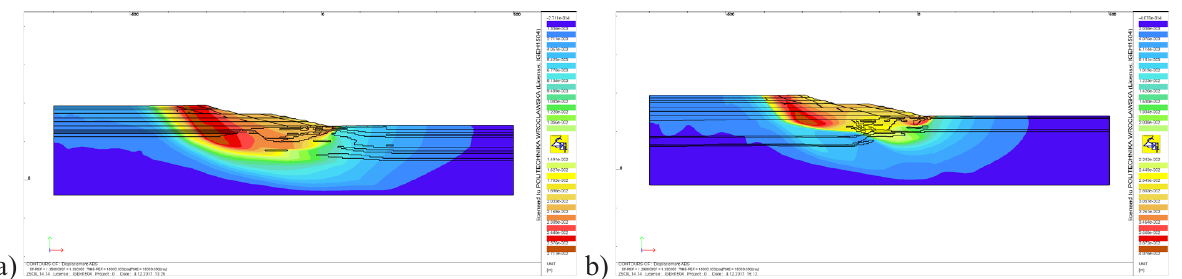
Fig. 10. Vertical displacement ( u y [mm]) as a function of dam elevation: a ) cross- section VIIIN and b ) cross- section VaN.